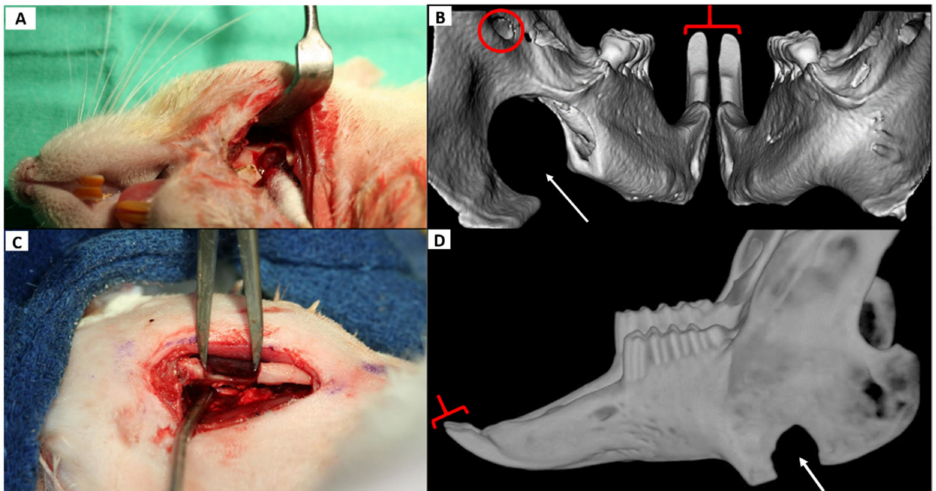
Figure 4. Critical size defect (CSD) in the rat and rabbit alongside reconstructed µ CT & CBCT images. In both animals, the defect is in the anterior ramus. ( A ): Surgical creation of the CSD in the rat. The metal retractor is reflecting the masseter and skin and the Q-tip is medializing the medial pterygoid to show the 5 mm defect. ( B ): A 3D CT reconstruction of the rat mandible from a caudal (posterior) vantage point 3 weeks following the surgery. The defect (thin arrow) remained fairly unchanged and symmetric incisor morphology (brackets) can be seen which was present at all time points. The circle indicates the mandibular foramen which transmits the inferior alveolar NVB. ( C ): Surgical creation of an 8 mm CSD in the anterior ramus of a rabbit with caliper shown. ( D ): A lateral 3D CT reconstruction of the same rabbit mandible 10 weeks later (the caudal view used in the rat was not suitable in the rabbit as it did effectively reveal relevant anatomy in a single view.) Note the CSD (thin arrow) is largely preserved as is symmetric incisor morphology (bracket) which was maintained at all measured time points. CSD: critical size defect, µ CT= micro computed tomography, CBCT= cone beam computed tomography, NVB = neurovascular